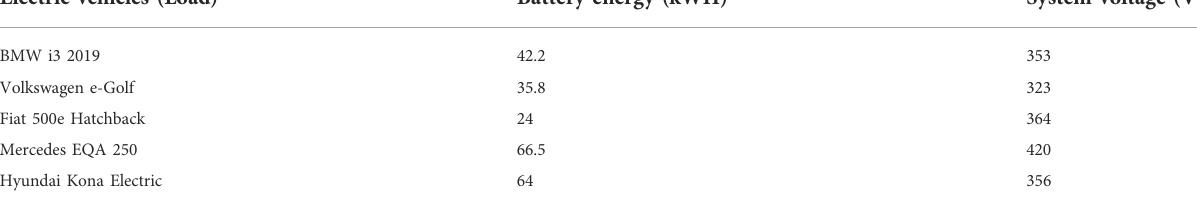
TABLE 3 Li-ion battery datasheets.